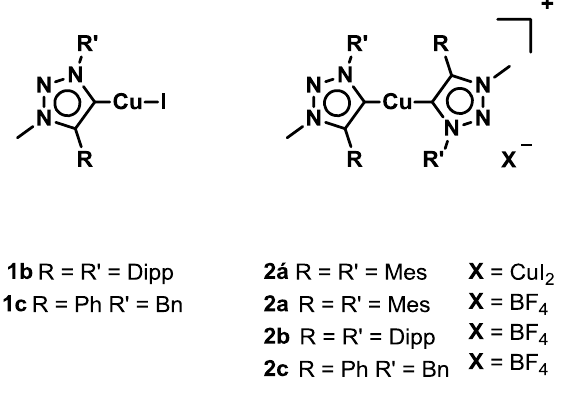
Figure 1. Overview of the copper complexes used.